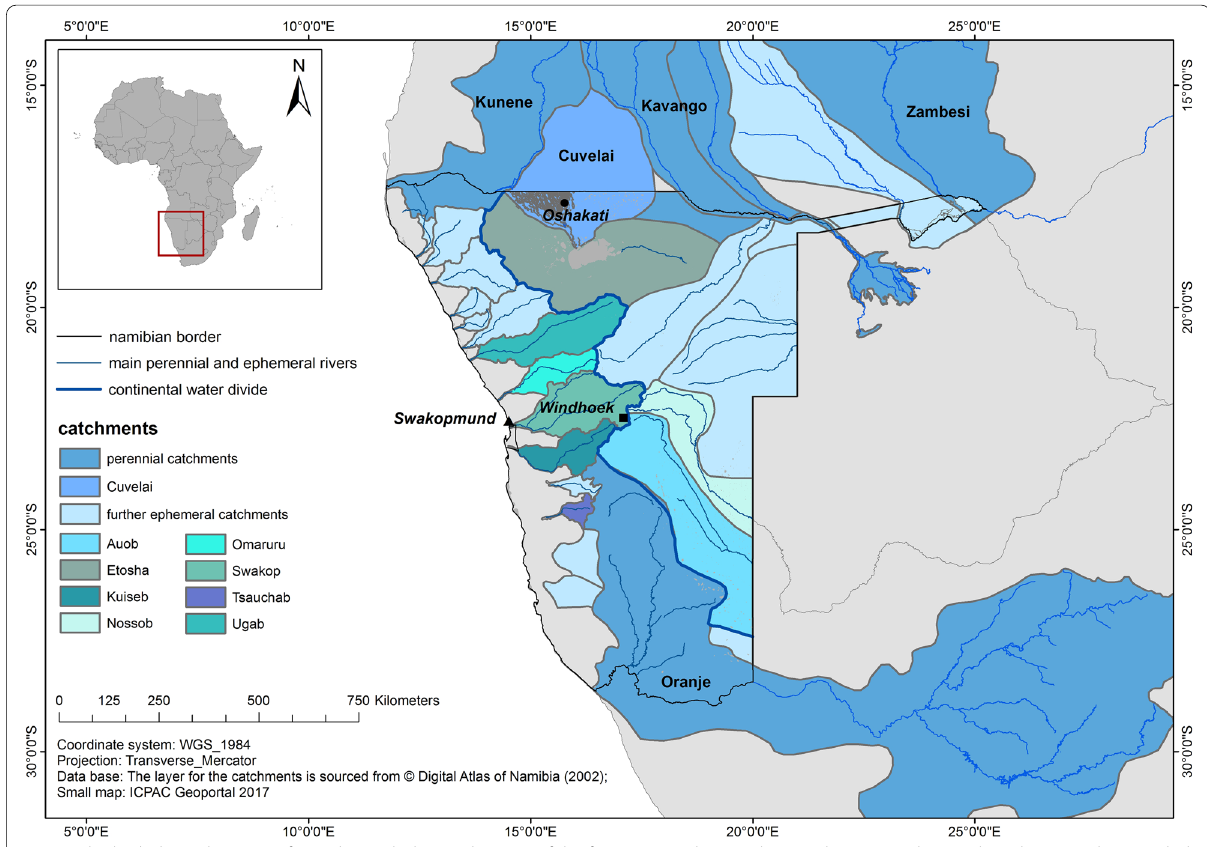
Fig. 1 The hydrological system of Namibia with the catchments of the four perennial rivers, the Cuvelai Basin, ephemeral catchments (the sampled are colored), and the continental water